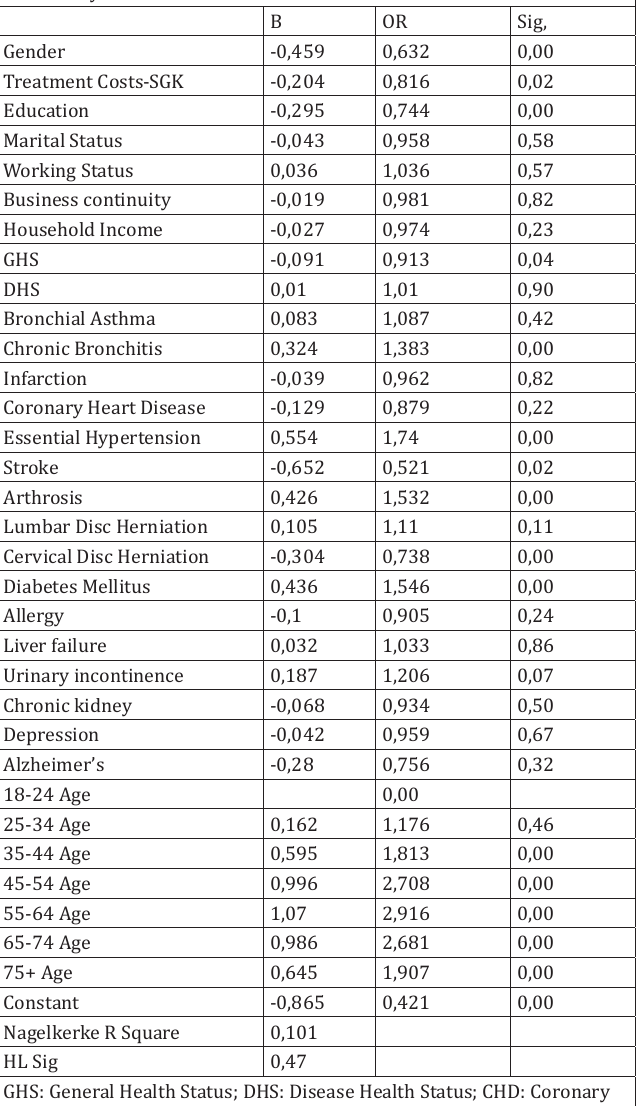
Chronic Diseases and the Effect of Added Table 5 Socio-Demographic Variables on BMI